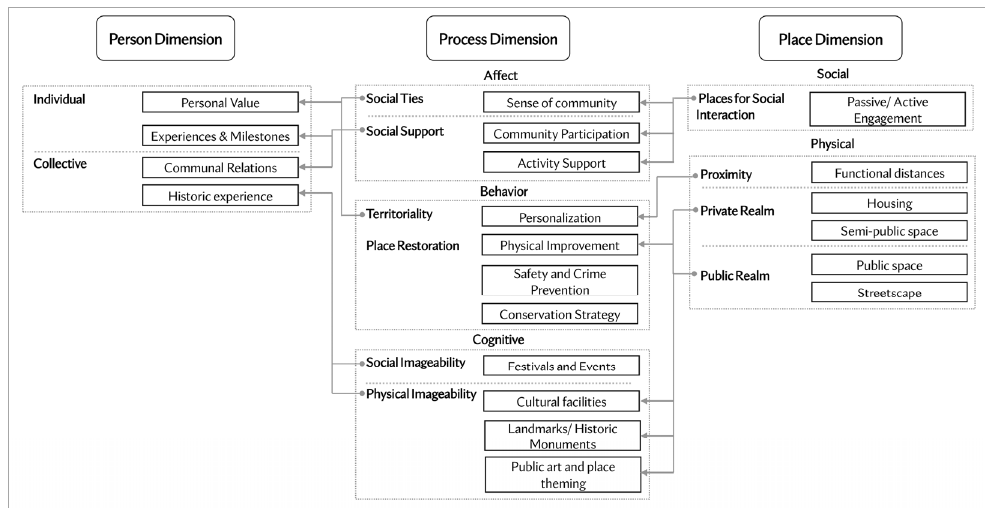
Figure 1. People–Place–Process Framework of Place Attachment.